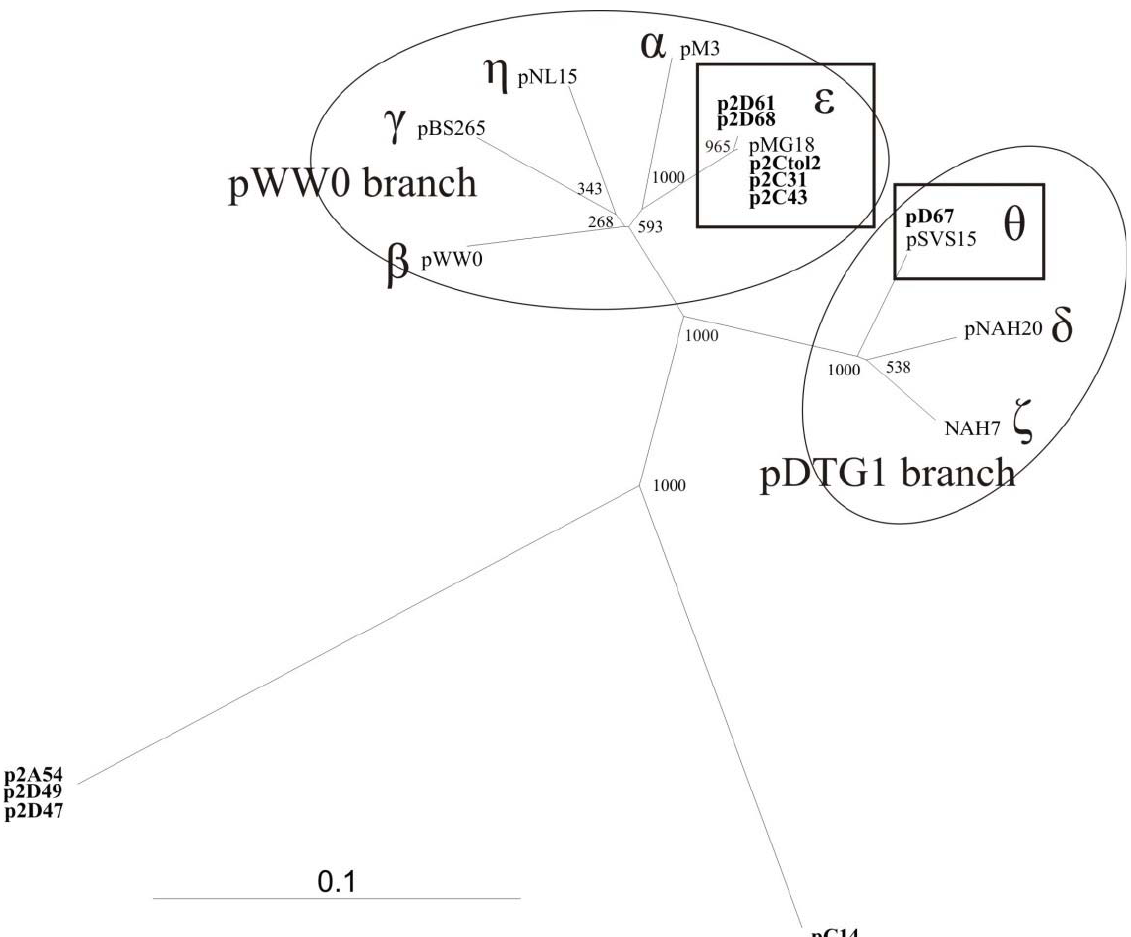
Figure 1. Phylogenetic analysis of repA gene sequences amplified with IncP-9 plasmid-targeted primers. Neighbor-joining unrooted phylogenetic tree of IncP-9